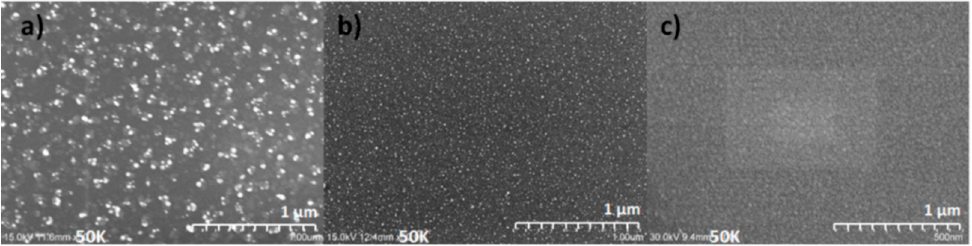
Figure 9. Scanning electron microscope (SEM) of Ag doped CeO 2 in different CeO 2 deposited at 200 °C: Ag ratios: ( a ) 10:1; ( b ) 20:1; and ( c ) 30:1.